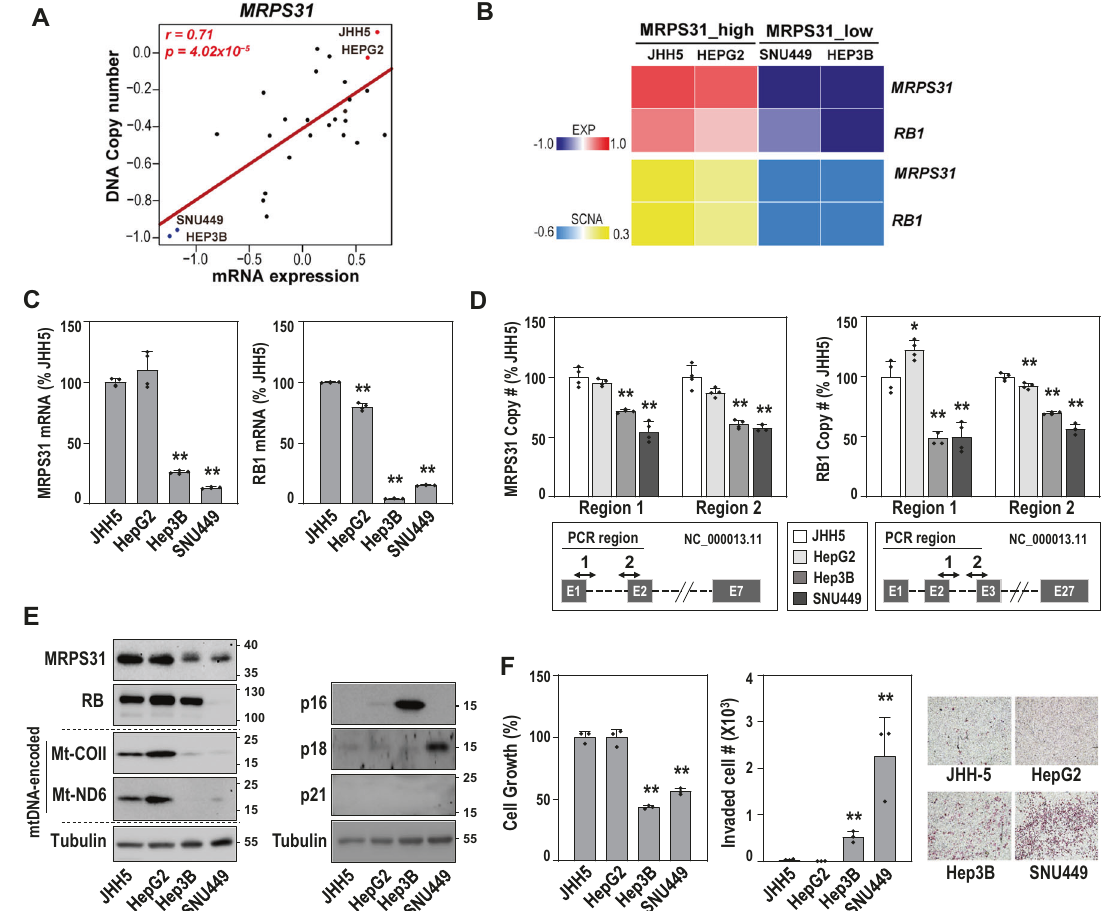
Fig. 3 Hepatoma cells with MRPS31 loss displays high cell invasion activity. A Scatter plot of the association between mRNA level and DCN of MRPS31 of the 27 HCC cell lines. The statistical r and p values by Pearson ’ s product-moment correlation test are noted. Cell lines with top two highest (red) and two lowest (blue) MRPS31 levels are indicated. B Heatmap of mRNA levels and DCN of MRPS31 and RB1. C qRT-PCR quanti fi cation of four independent experiments. D DCN of MRPS31 (left) and RB (right) by performing genomic PCR against two different DNA regions (lower panels) for each gene ( N = 4 for quanti fi cation). E Western blots. Protein expressions of two mtDNA-encoded genes, COII (Mt- COII) and ND6 (Mt-ND6) were included. F Cell growth (left) and cell invasiveness (middle). Representative images of invaded cells (right) are shown ( N = 3 for quanti fi cation). ** p < 0.01; * p < 0.05 vs. JHH5 by unpaired two-way student t